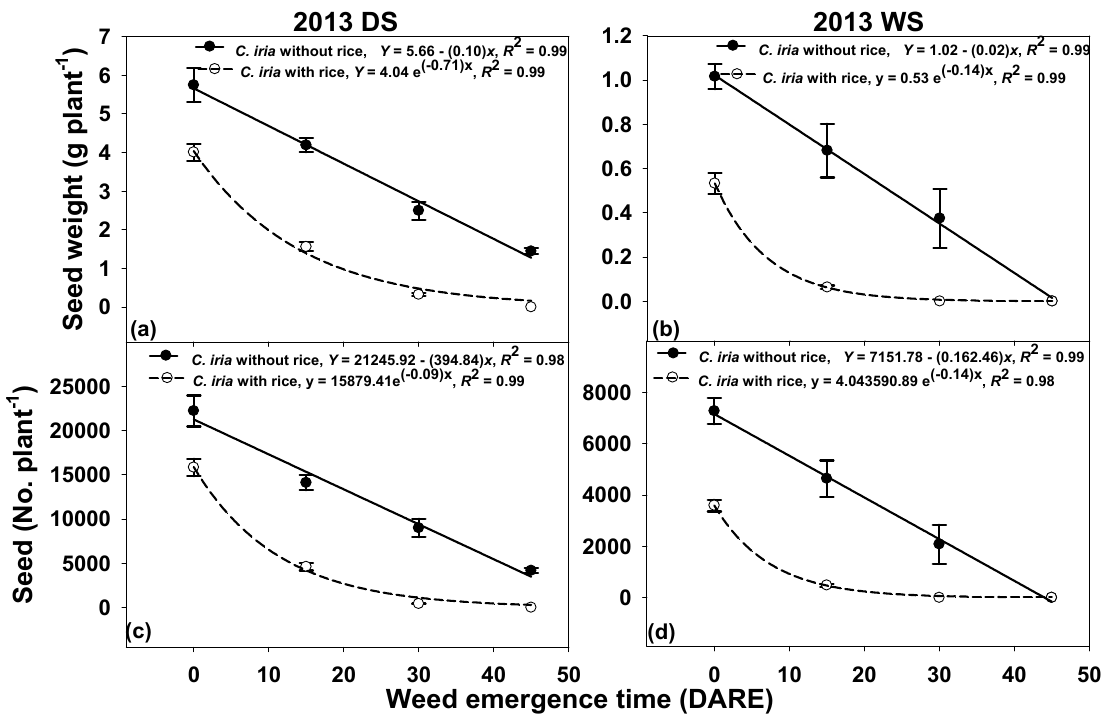
Figure 4. Regression curves ( y = a + bx and y = a. e – bx ) fitted to the seed weight ( a , b ) and seed number ( c , d ) plant − 1 of C. iria . Models fitted to the data for C. iria grown without rice interference (Rice 0) are shown by solid lines, and those fitted to the data for C. iria grown with rice at the rate of a 50 kg ha –1 seed rate (Rice 50) are shown by broken lines. Equations represent the estimated parameters. The standard error of the means is represented by vertical bars.